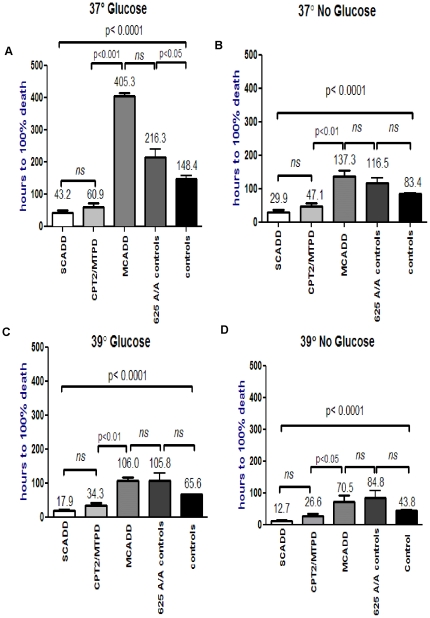
Comparison of menadione toxicity in short-chain acyl-CoA dehydrogenase
deficiency (SCADD), medium-chain acyl-CoA dehydrogenase deficiency (MCADD),
carnitine palmitoyltransferase 2 deficiency (CPT2D) and mitochondrial trifunctional
protein deficiency (MTPD)/long-chain L-3hydroxyacyl-CoA dehydrogenase deficiency
patients and 625A/A controls (n = 4) and 625G/A and G/G
(n = 9) control data under the 4 experimental conditions.One-way ANOVA and Bonferroni's Mutiple Comparison test compares menadione
toxicity, after logarithmic transformation to ensure Gaussian distribution.
The ANOVA shows significant differences between all groups, in all 4 experimental
conditions, indicated by the error bar spanning all cell lines, p<0.0001(Table S1).
The Bonferroni subgroup analyses are summarized in Table S3, and indicated by the error bars comparing
2 cell lines. Figures 1a to d
displays the significantly reduced time to 100% cell death in the SCADD
and CPT2/MTPD patient cell lines, compared to the 625A/A control and normal
control (625 G/G and 625 G/A) cell lines. The MCADD cell lines survived significantly
longer than the normal control cell lines, only at physiological conditions
(Table S3). Figures 1b to 1d show the progressive
reduction in survival time to 100% cell death in all cell lines, with
the addition of glucose deprivation (Figure
1b), elevated temperature (Figure
1c), or both (Figure 1d).